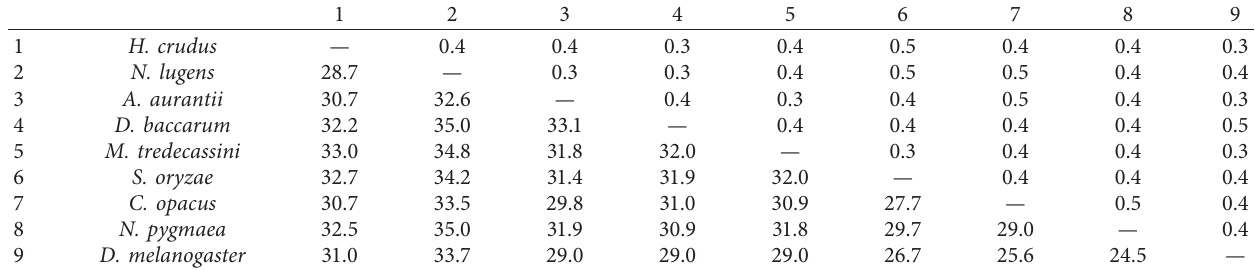
Table 3: Pairwise comparison of the entire mitochondrial genome of various insect taxa relative to Haplaxius crudus representing percent difference in sequence